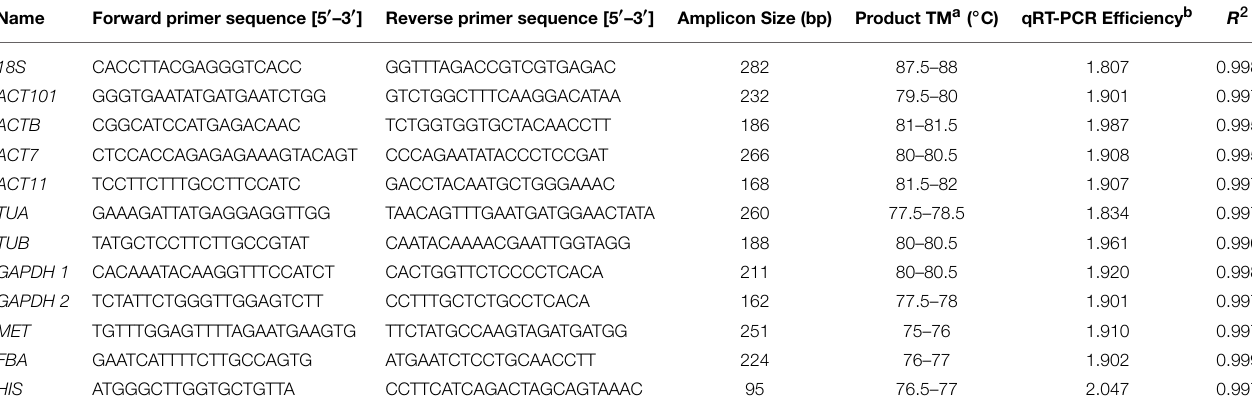
TABLE 2 | List of primer sequences of the candidate reference genes and their amplification efficiencies. Name